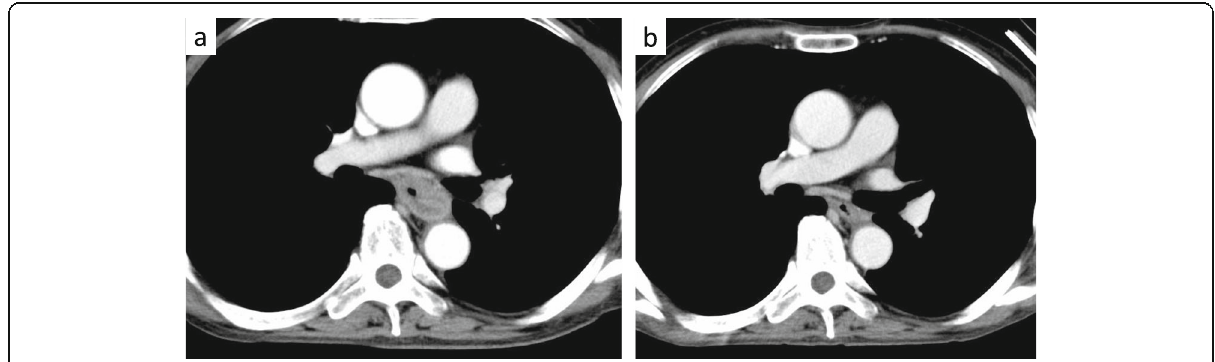
Fig. 1 Chest CT scan showing a the esophageal cancer contacts to the left main bronchus and both the lower lobe of the lung before NAC. b After neoadjuvant chemotherapy, esophagus wall thickening had somewhat improved. However, invasion of adjacent organs could not be ruled